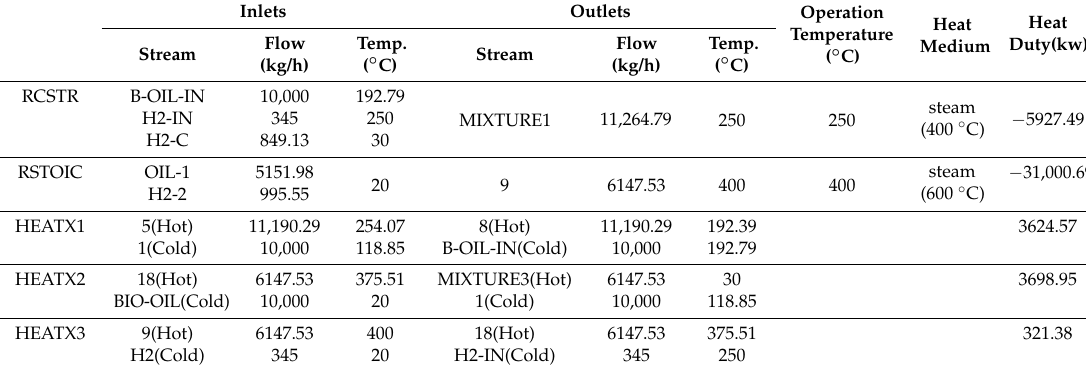
Table A4. Energy analysis of the overall process at 250 ◦ C and 5.6 MPa and deep hydrogenation at 400 ◦ C and 15 MPa.